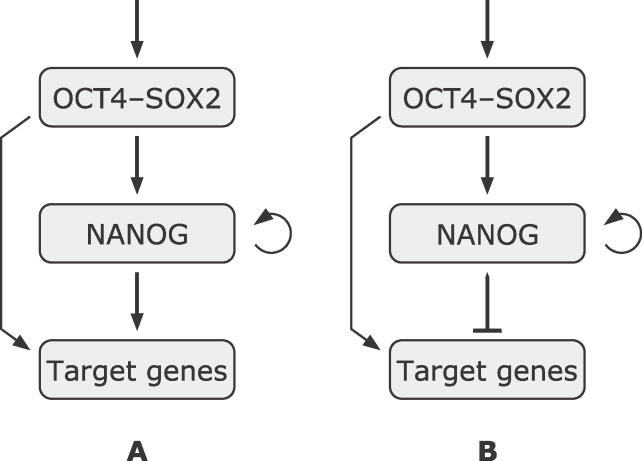
Coherent and Incoherent Feedforward Network Motifs(A) Coherent.(B) Incoherent.